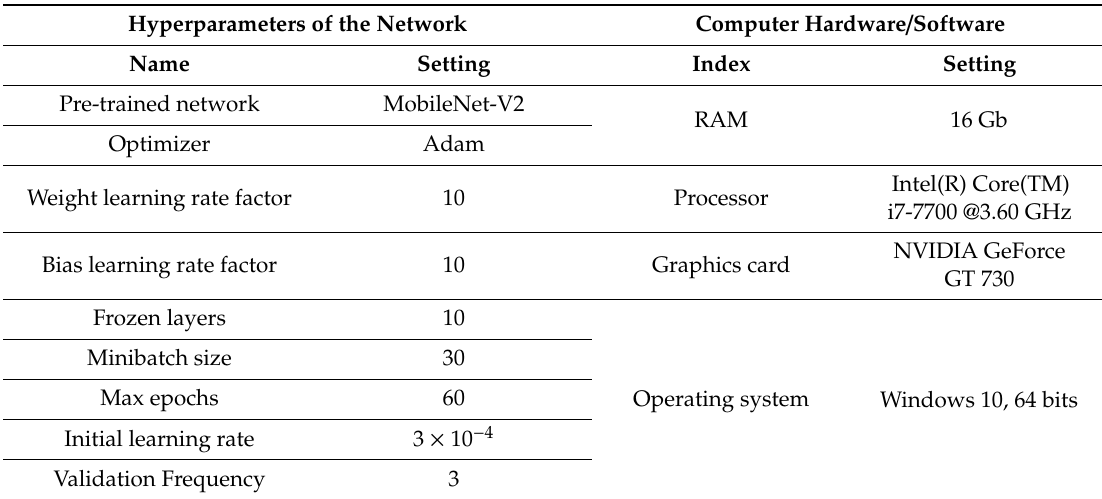
Figure 6. Data visualization and transfer learning. Table 4. The hyperparameters of the CNN-based network and the computer configuration